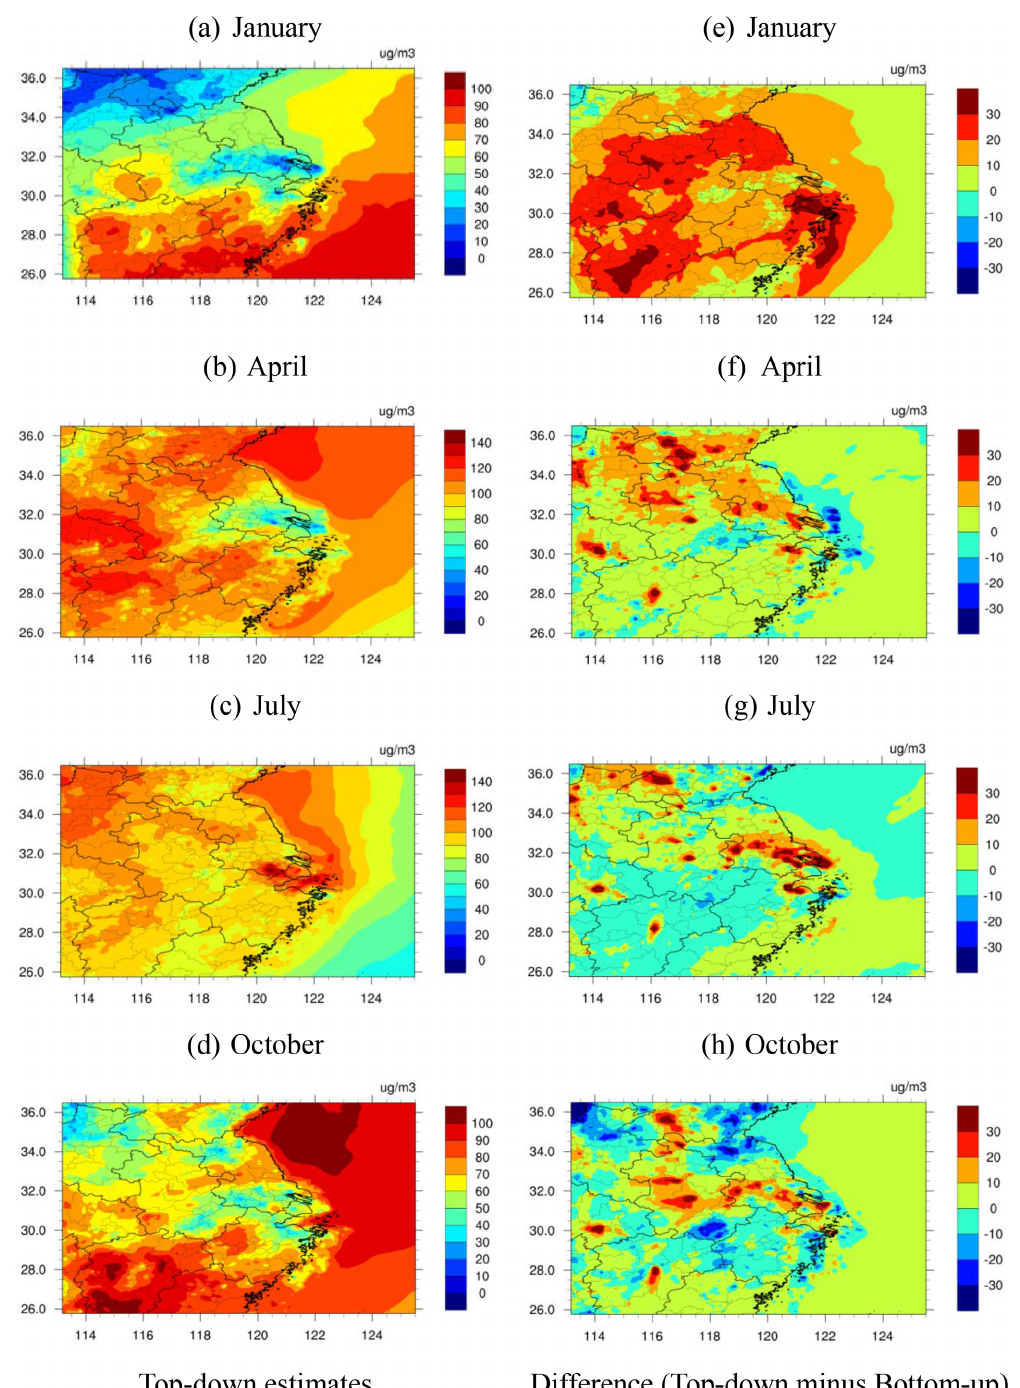
Figure 7. The spatial distribution of the simulated monthly mean O 3 concentration with the top-down NO x estimates and the spatial differ- ences between the simulations with the top-down and bottom-up NO x emissions in January, April, July, and October 2016 (top-down minus